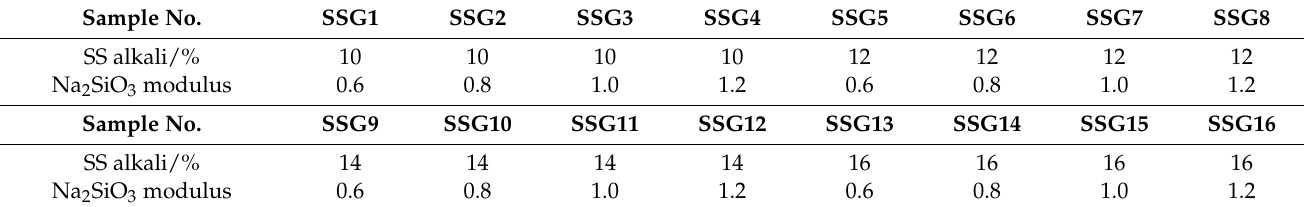
Table 5. Mixed activator ratio test